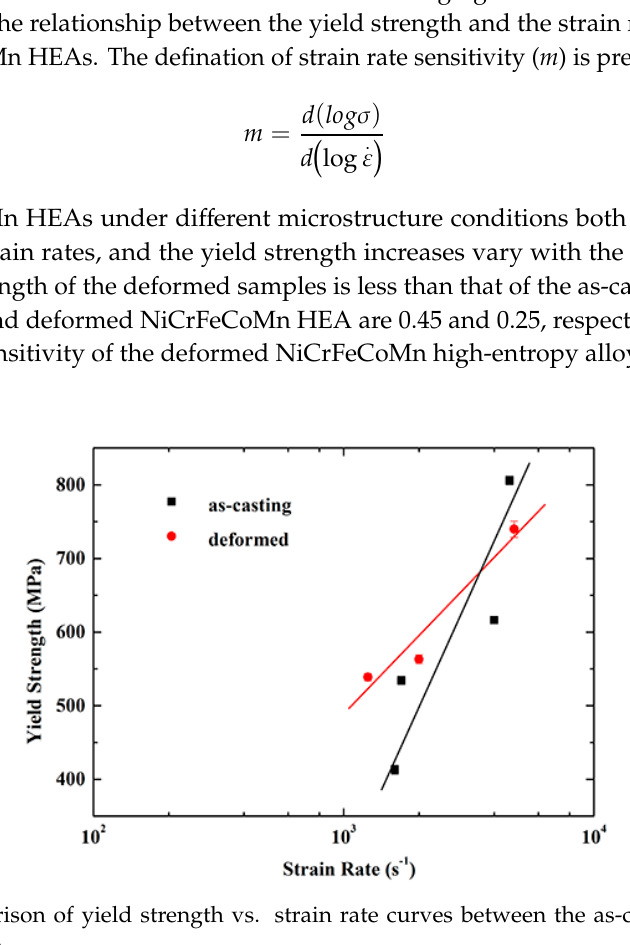
Figure 7. Comparison of yield strength vs. strain rate curves between the as-cast and deformed NiCrFeCoMn NiCrFeCoMn HEA.